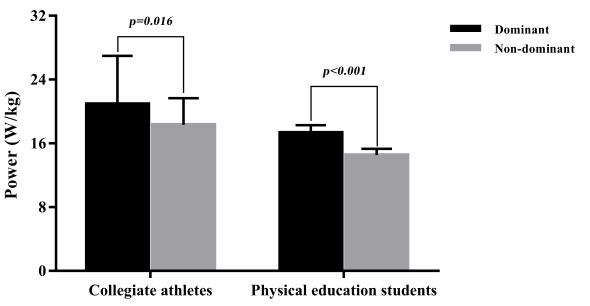
Fig. 6. Comparison of lower limb power of dominant and non- dominant leg at